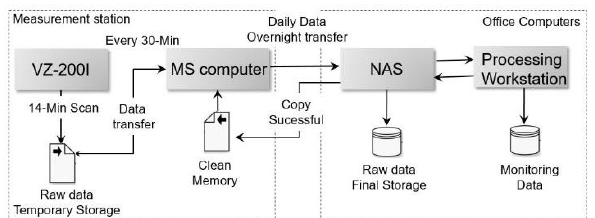
Figure 2. Data acquisition workflow of the TLS measurement station.